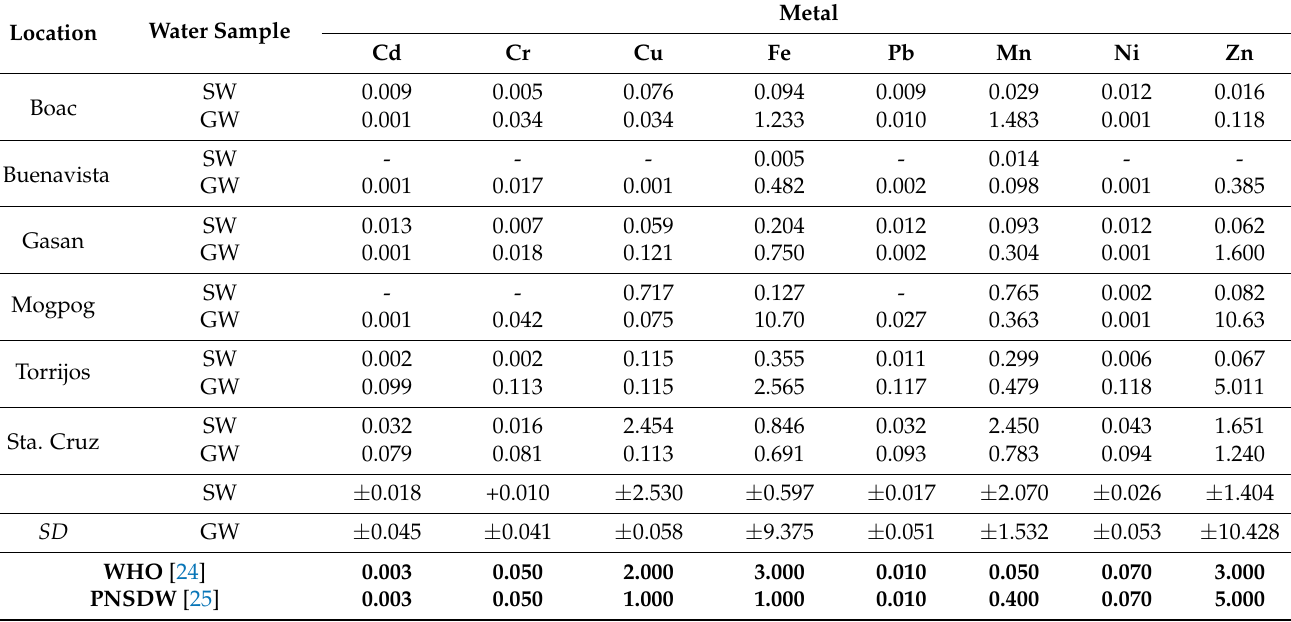
Table 3. Average concentration of metals in water samples (mg L − 1 ) with maximum permissible limit (MPL). Location